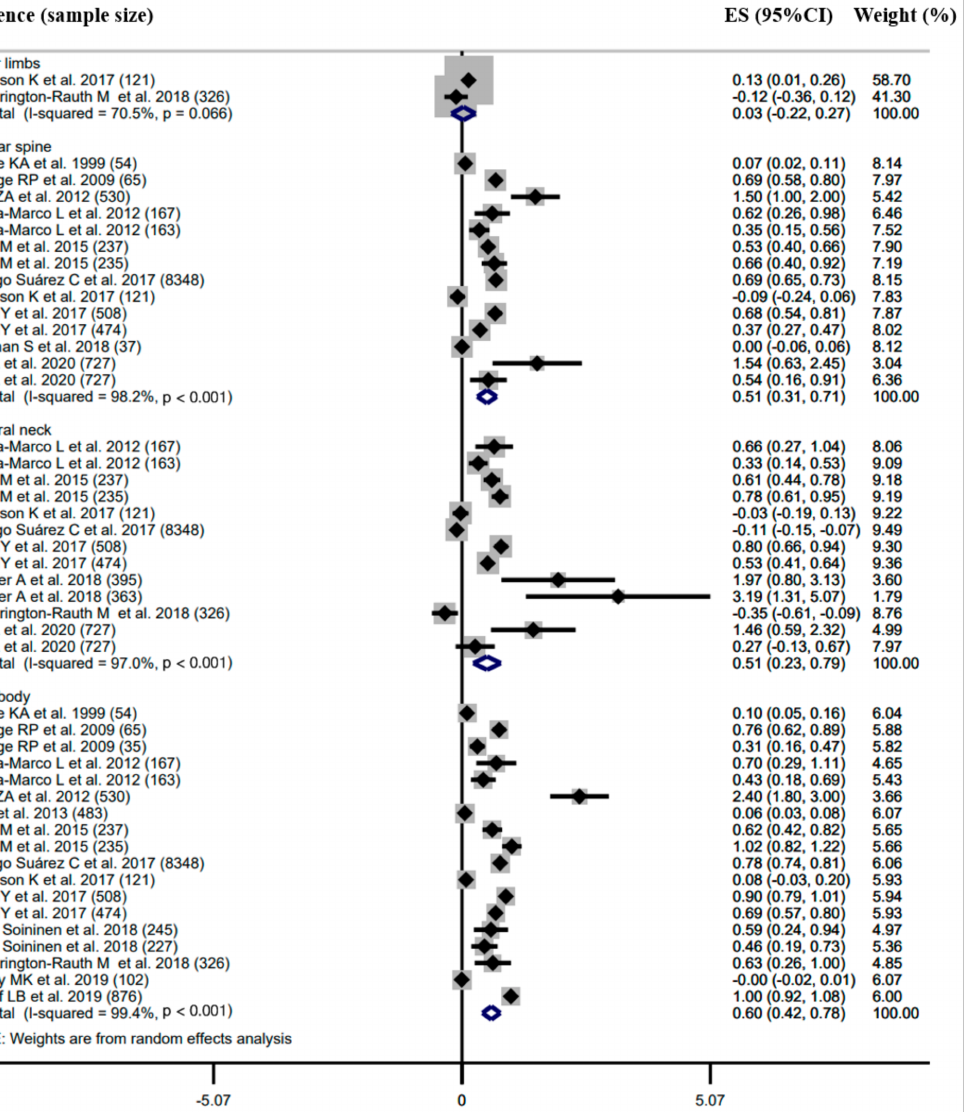
Figure 2. Forest plot of association (regression coefficient) between lean mass (LM) and bone mineral density (BMD) in upper limbs, lumber spine, femoral neck and total body, respectively. The effect size (ES) and 95% confidence interval (CI) for fully adjusted random effects are depicted for each